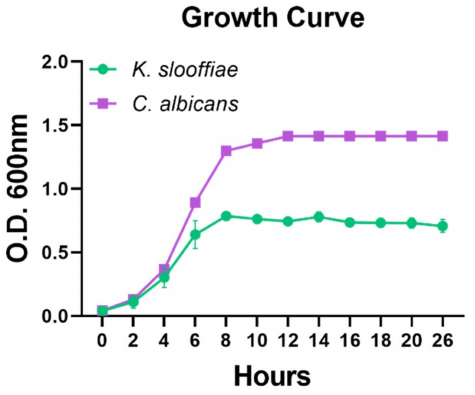
Figure 3. Growth curves of planktonic fungi. A) Kazachstania slooffiae (pig isolate, n = 26 replicates) and Candida albicans CHN1 (human isolate, n = 9 replicates). Data shown are the mean of replicates with error bars representing the standard